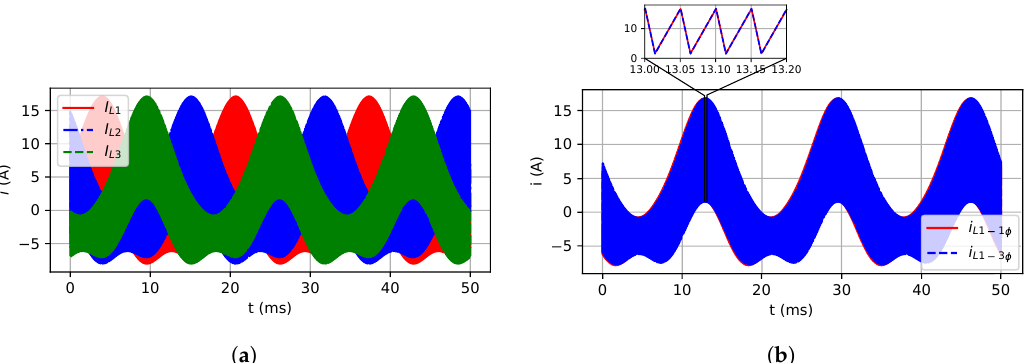
Figure 14. Inductor currents for RL load case: ( a ) Three-phase model; ( b ) Single-phase and three-phase (leg 1) models.